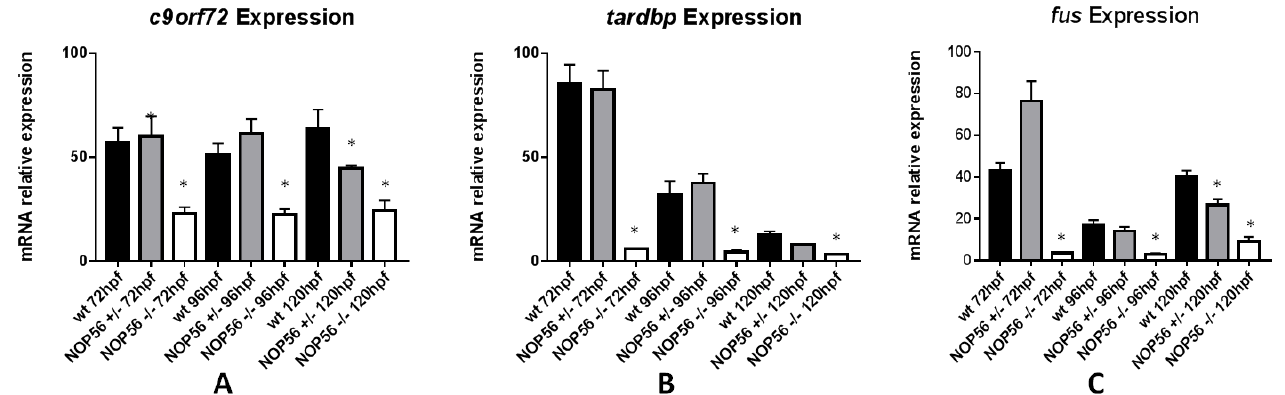
Figure 14. Graphic representation of mRNA expression analysis by RT-qPCR. ( A ) c9of72 expression is significantly reduced in nop56 − / − embryos between 72 and 120 hpf ( p -value < 0.001) and in nop56 +/ − at 120 hpf ( p -value=0.0015). ( B ) tardbp expression is significantly reduced in nop56 − / − embryos between 72 and 120 hpf ( p -value < 0.001). ( C ) fus expression is significantly reduced in nop56 − / − embryos between 72 and 120 hpf ( p -value < 0.0001) and in nop56 +/ − embryos at 120 hpf ( p -value < 0.0001). Statistically significant data in the graphs are indicated with a *.